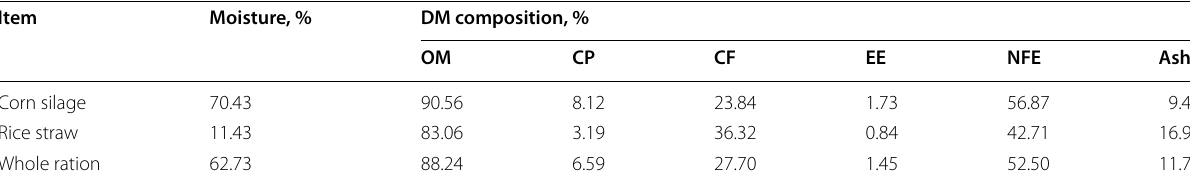
Table 1 Chemical composition of feedstuffs and the whole 100% roughage ration